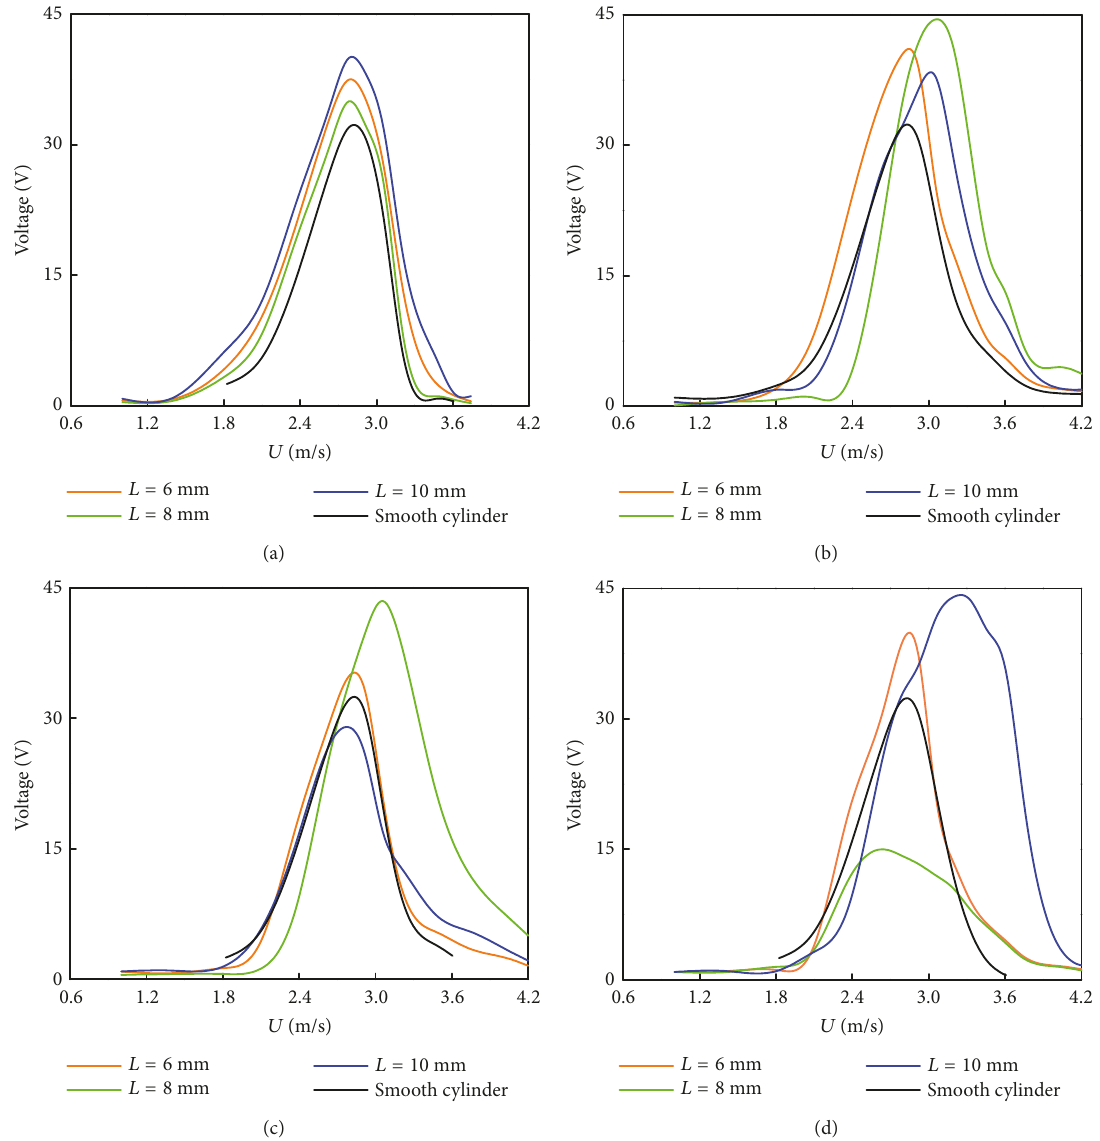
Figure 7: Measured piezoelectric energy harvester data (no resistance): (a) peak voltage versus wind speed of 3 columns of pits; (b) peak voltage versus wind speed of 4 columns of pits; (c) peak voltage versus wind speed of 5 columns of pits; (d) peak voltage versus wind speed of 6 columns of